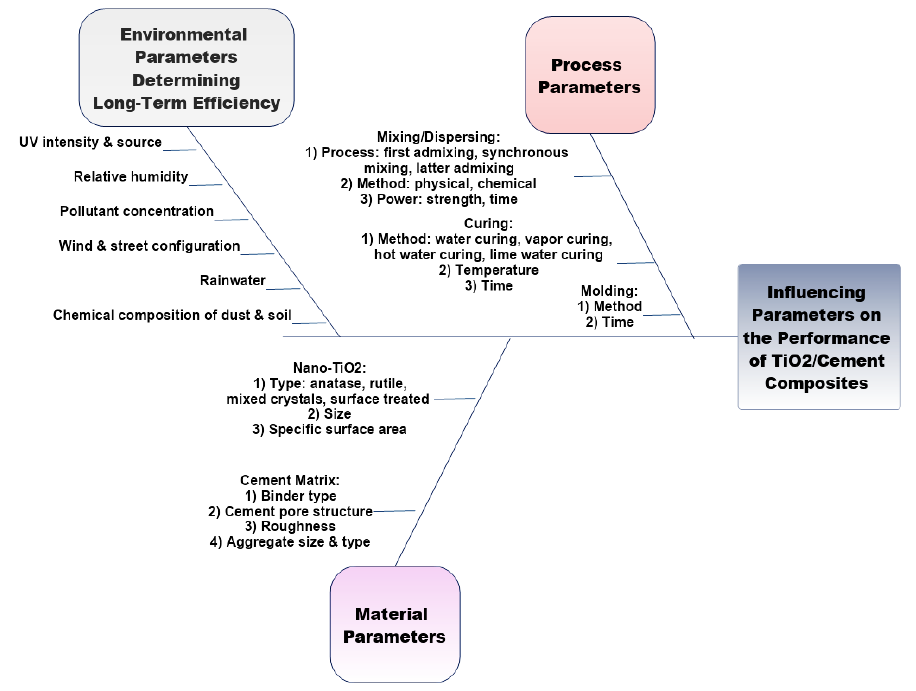
Figure 16. Influencing parameters affecting the performance of photocatalytic cement-based materials extracted from [137,155,166 – 169].